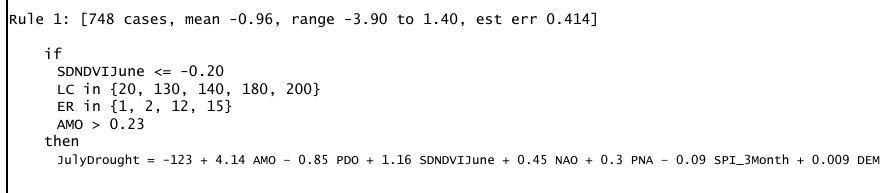
Figure 3. An excerpt rule produced in a June one-month outlook model for predicting July drought. In rule 1, the land cover and ecological region (ER) are categorical values. For the land cover, 20 = Mosaic cropland (50%–70%)/vegetation (grassland/shrubland/forest) (20%–50%); 130 = Closed to open (>15%) (broad-leaved or needle-leaved, evergreen or deciduous) shrubland (<5 m); 140 = Closed to open (>15%) herbaceous vegetation (grassland, savannas, or lichens/mosses); 180 = Closed to open (>15%) grassland or woody vegetation on regularly flooded or waterlogged (fresh, brackish or saline water); 200 = Bare areas. For the ER, 1 = Desert and semi-desert scrubland (DSS); 2 = Acacia-Commiphora woodland and bush land proper (ACB); 12 = Freshwater marshes and swamps, floodplains, and lake shore vegetation (FLV/MFS); 15 = Salt pans, saline/brackish and intermittent wetlands, and salt-lake shore vegetation (SLV/SSS).